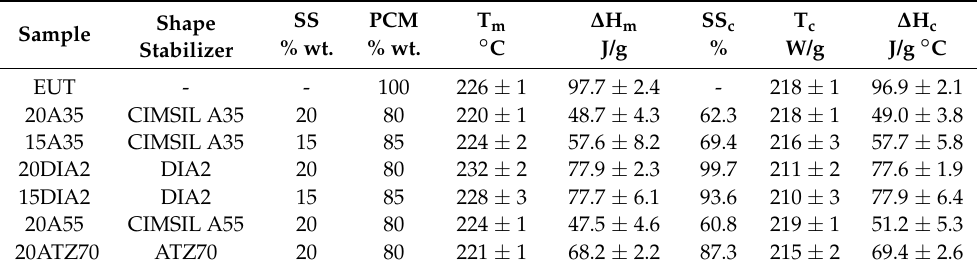
Table 3. Thermal characteristics of the SSPCM (EUT-based) obtained from the analysis by differential scanning calorimeter on the 2nd heating/cooling